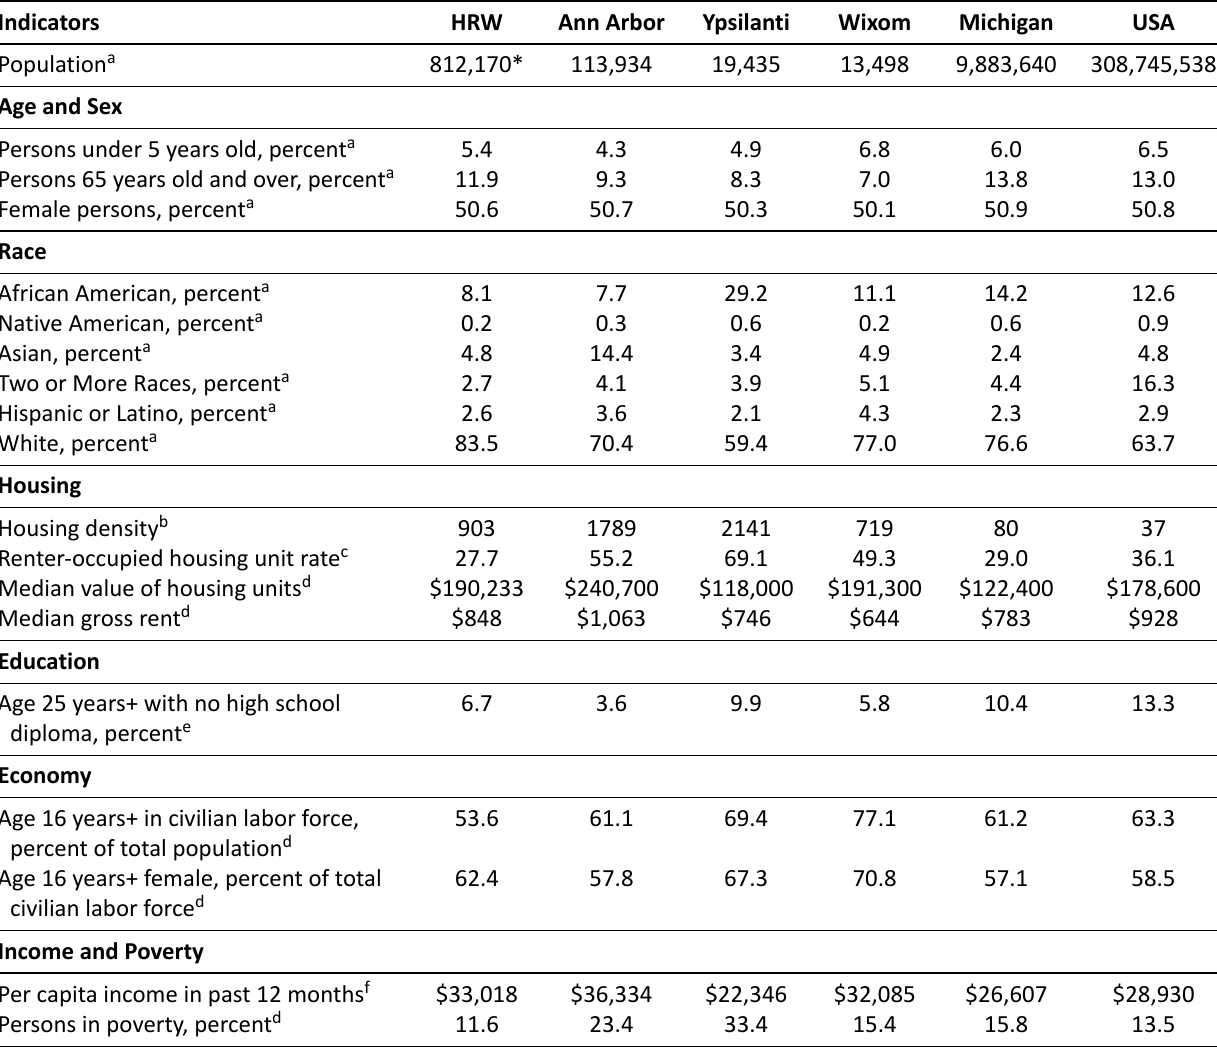
Table 1. Summary of commonly used socio-economic indicators of social vulnerability in U.S. census data across the Huron River watershed (HRW), three cities containing large Climate Justice areas in the watershed (Ann Arbor, Ypsilanti, and Wixom), the state of Michigan, and the